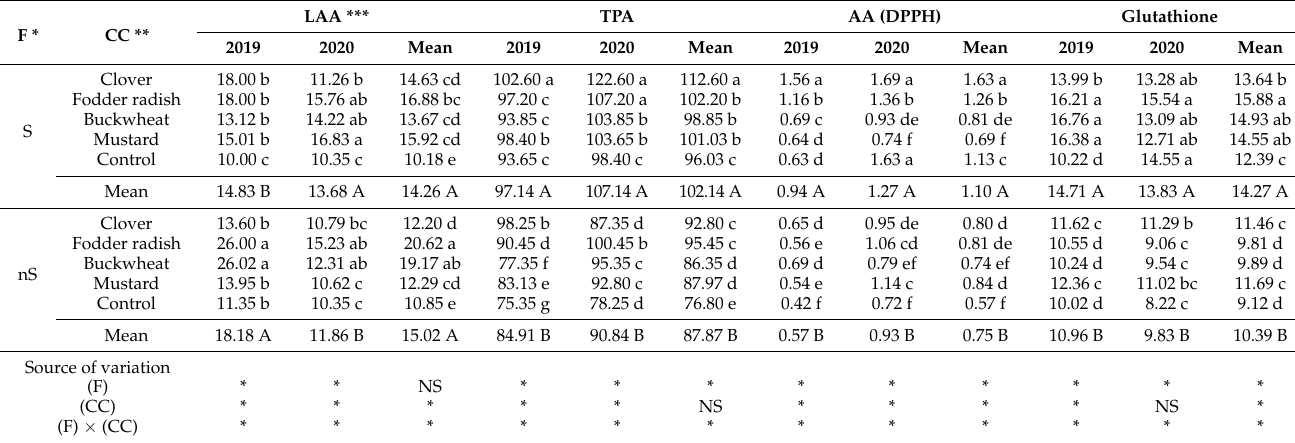
Table 5. Bioactive compound content in bulb winter garlic cultivated under sulfur and catch crops in